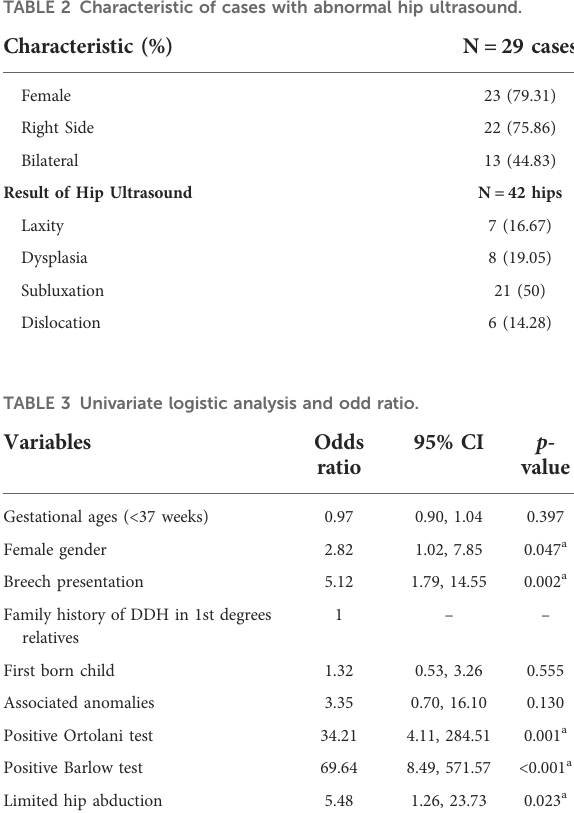
TABLE 2 Characteristic of cases with abnormal hip ultrasound.